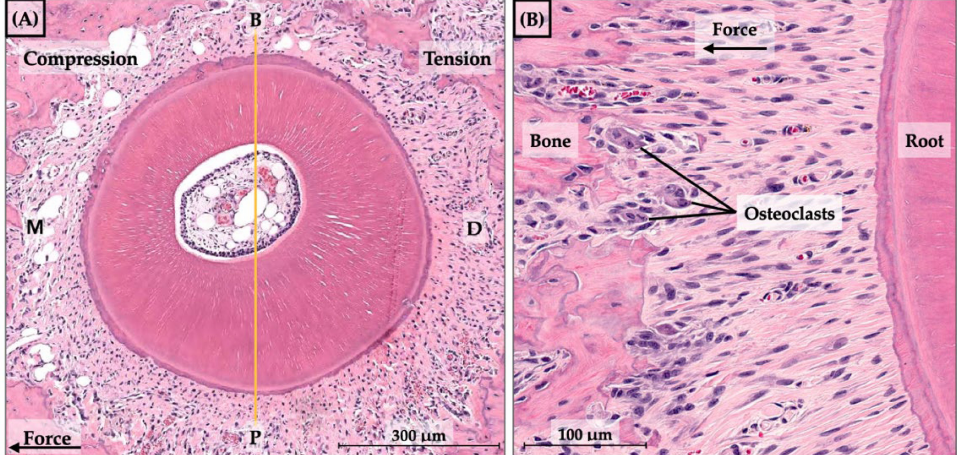
Figure 4. ( A ) Histological sections of the distopalatal root of the maxillary first molar (magnification, 40 × ), M = mesial, D = distal, B = buccal, P = palatal. ( B ) Details of osteoclast cells around the alveolar bone